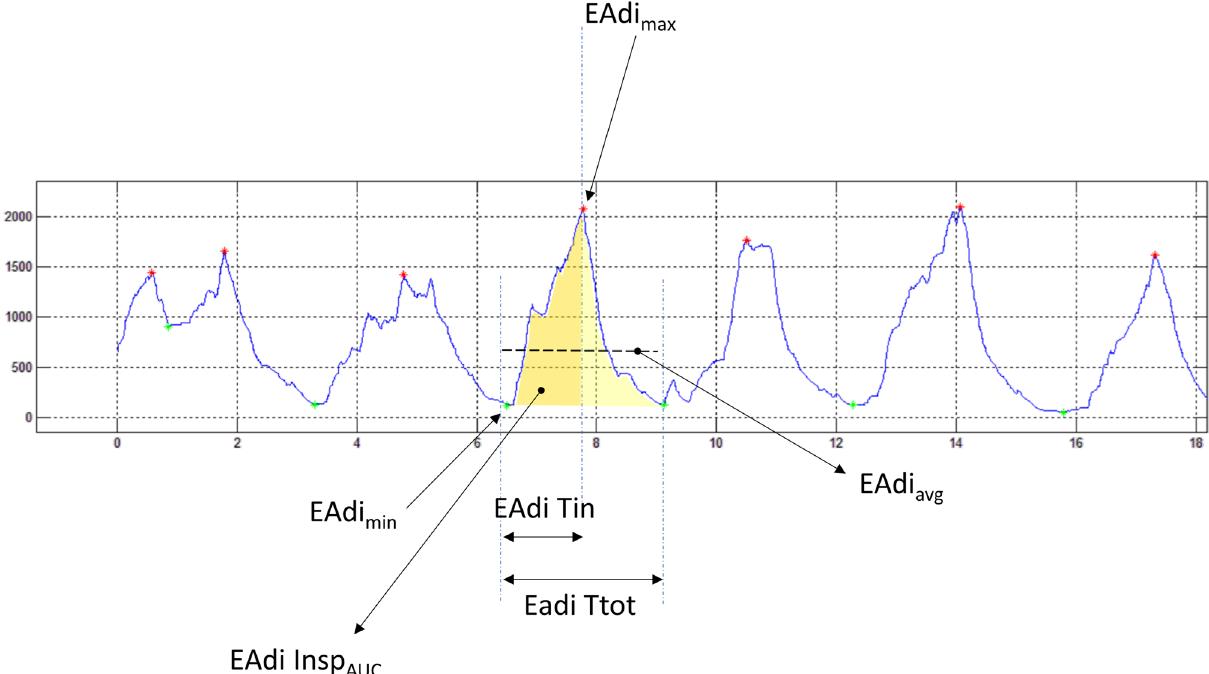
Figure 4. Matlab automatic EAdi analysis. EAdi electrical diaphragm activity, EAdi max peak electrical diaphragm activity, EAdi min electrical diaphragm activity, EAdi Insp AUC electrical diaphragm activity area of the inspiratory phase, EAdi Tin inspiratory time derived from electrical diaphragm activity, EAdi Ttot total respiratory time derived from electrical diaphragm